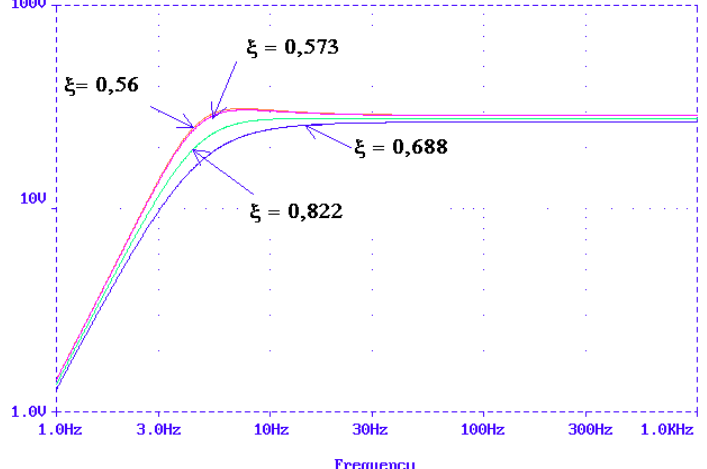
Figure 11. Frequency responses in dB of the model RCL.